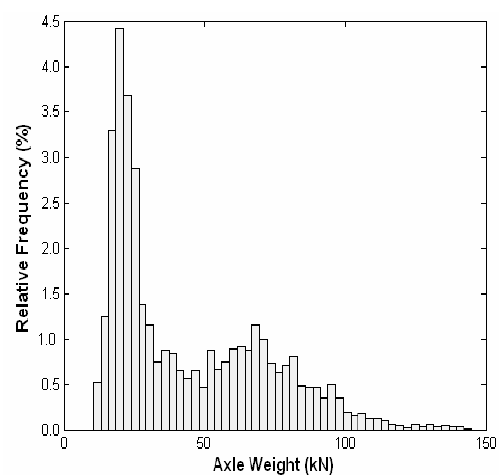
Fig 3. Observed and empirical